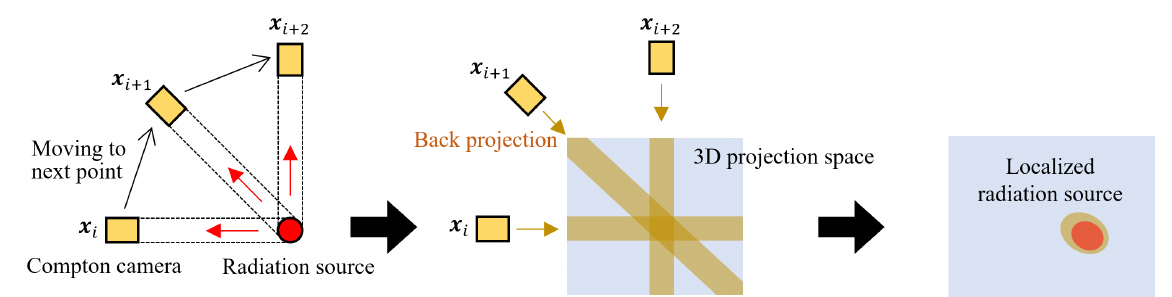
Figure 6. Reconstruction of radiation source distribution: the measurement data at each point is projected into the 3D voxel space via the simple back-projection method. Because the mobile robot can move in 2D space, the voxel data are projected onto a 2D